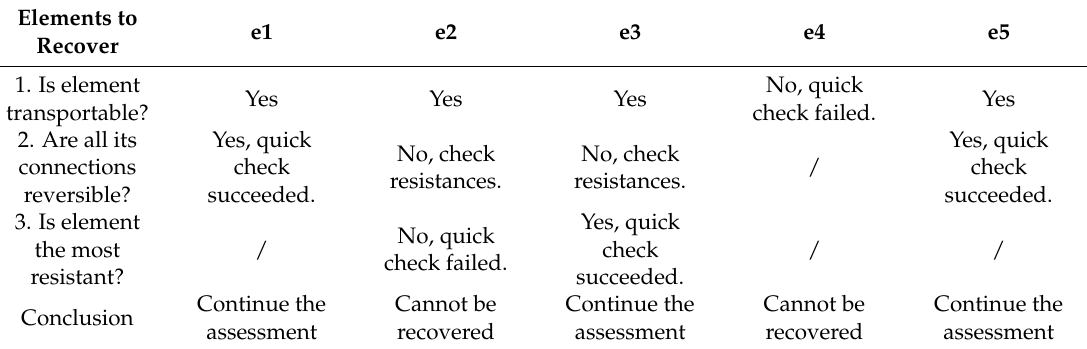
Table 5. Process and results of the first assessment step (quick check). All elements fulfill the requirements except the membrane (e2) and the masonry wall